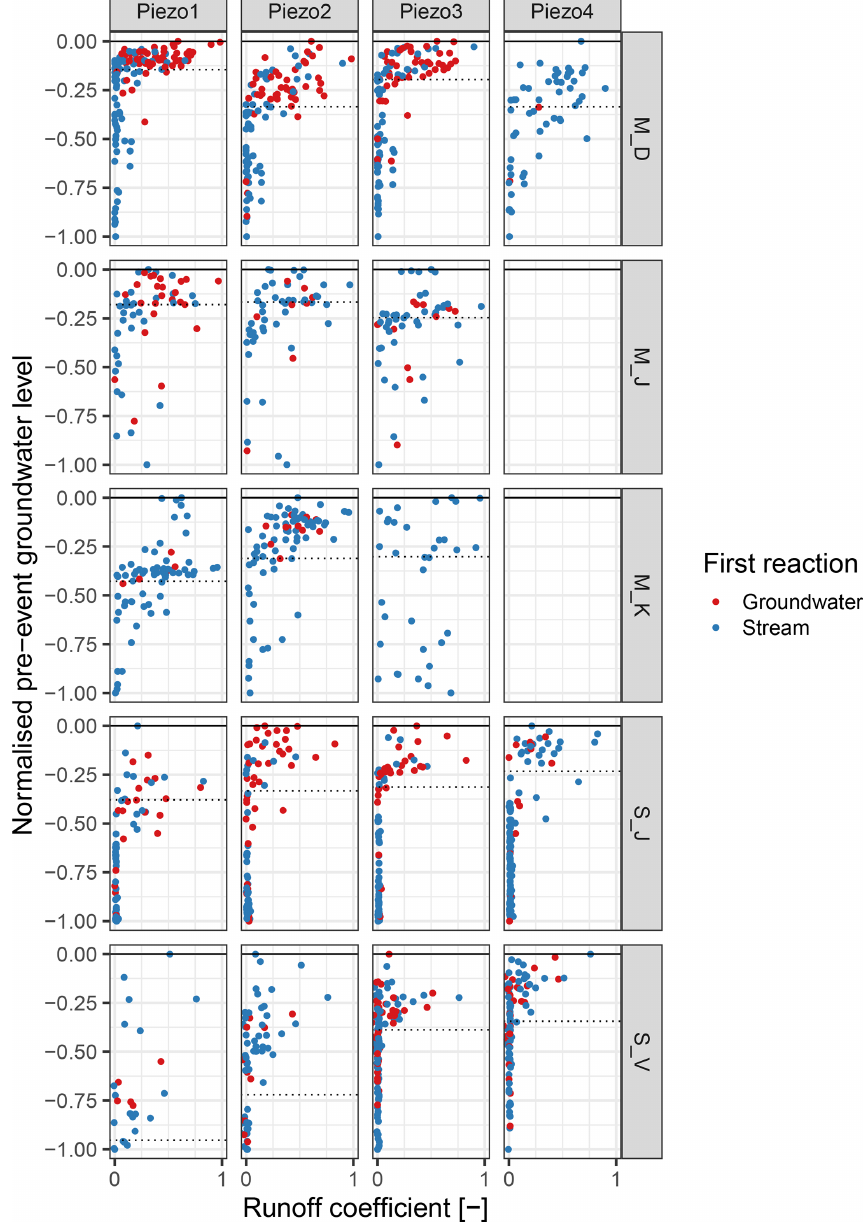
Figure 11. Event runoff coefficients versus shallow groundwater levels. Event runoff coefficients were determined for the Weierbach (schist) and Wollefsbach (marls) catchments where discharge data are available. The dotted horizontal lines illustrate the individual thresholds obtained from Fig. 10. The point colours indicate whether the groundwater levels (red) or the stream (blue) responded